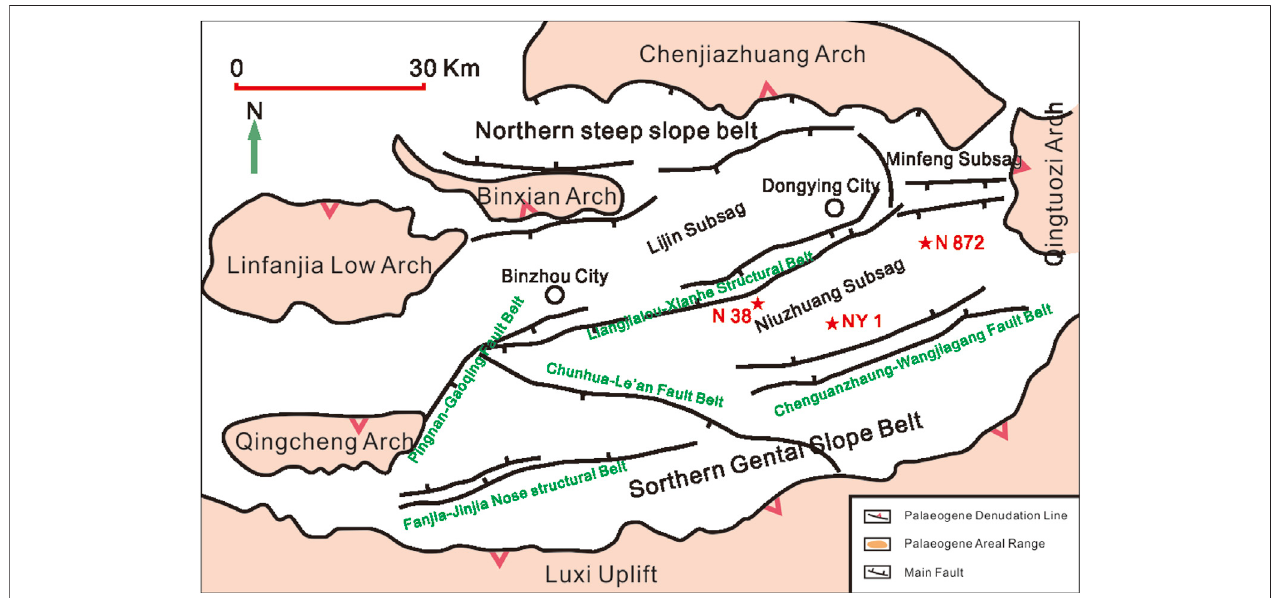
FIGURE 1 | Structural map and sampling well locations of the Dongying Sag (modi fi ed from Li et al., 2020).